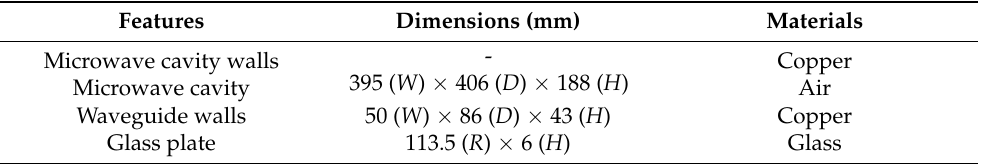
Table 1. Features of microwave oven system with dimensions and